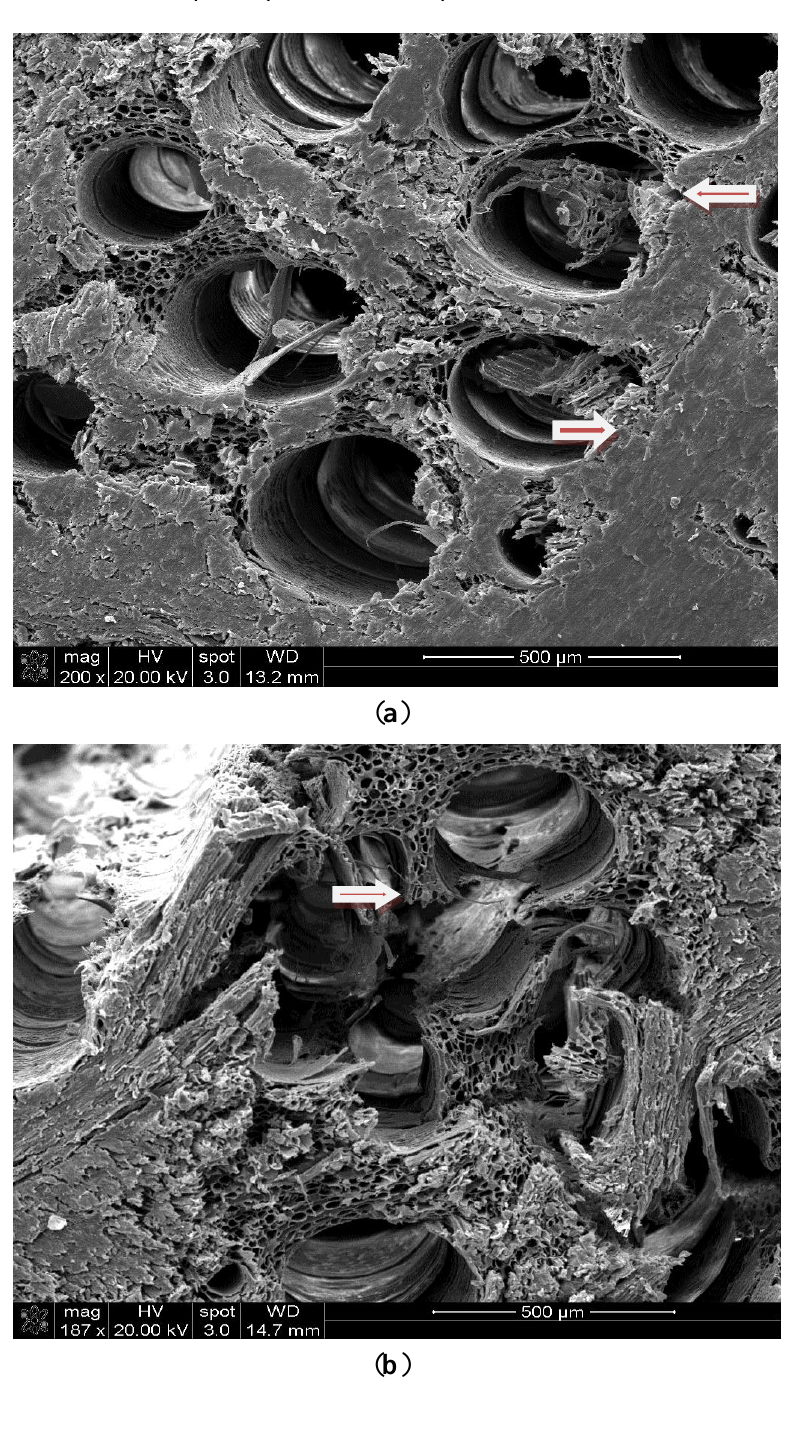
Figure 5. ( a ) Undamaged cell wall of control Southern red oak sample; ( b ) Damaged cell wall of Southern red oak sample exposed to a temperature of 200 °C for 8